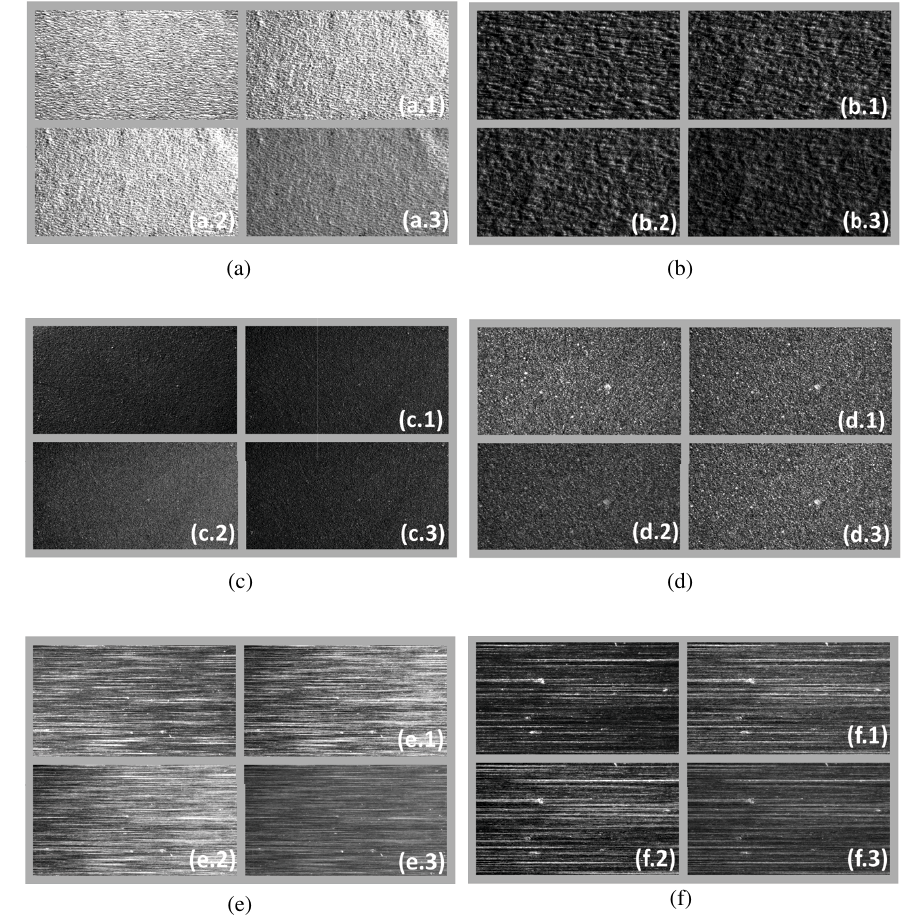
Figure 7. Example of images of appearance renderings with the three implemented models (random display) extracted from the DoE experimental videos (magnification: 40%; sampling density: